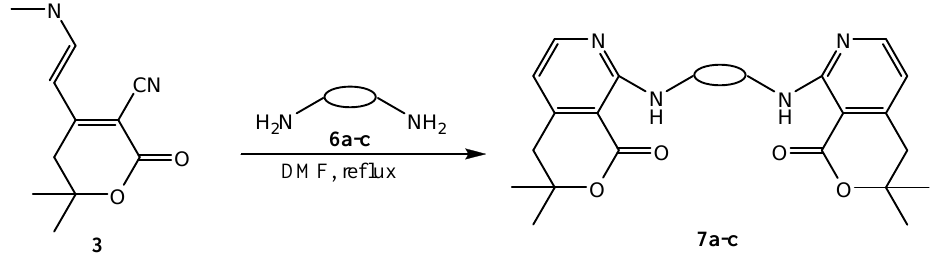
Table 1. Synthesis of 2-aminopyridine lactones.